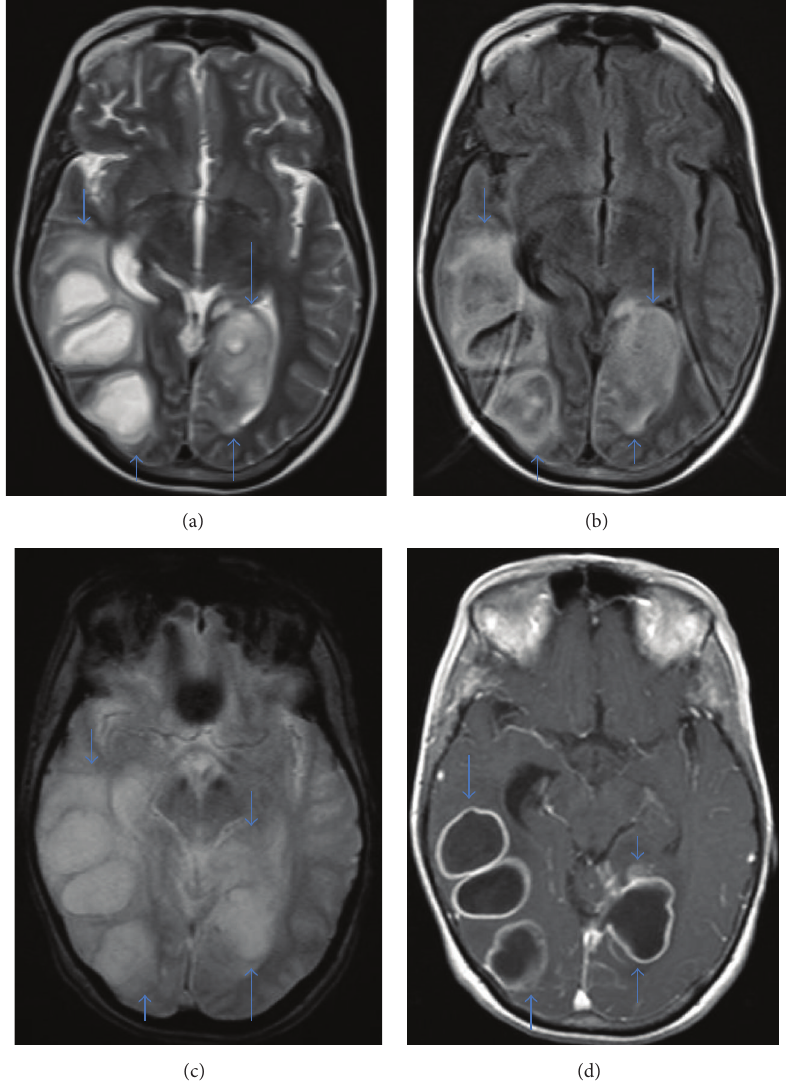
Figure 2: (a) Axial T2 weighted image, (b) axial FLAIR weighted image, (c) axial GRE weighted image, and (d) axial T1 weighted postcontrast image show bilateral temporal-occipital lobe abscesses